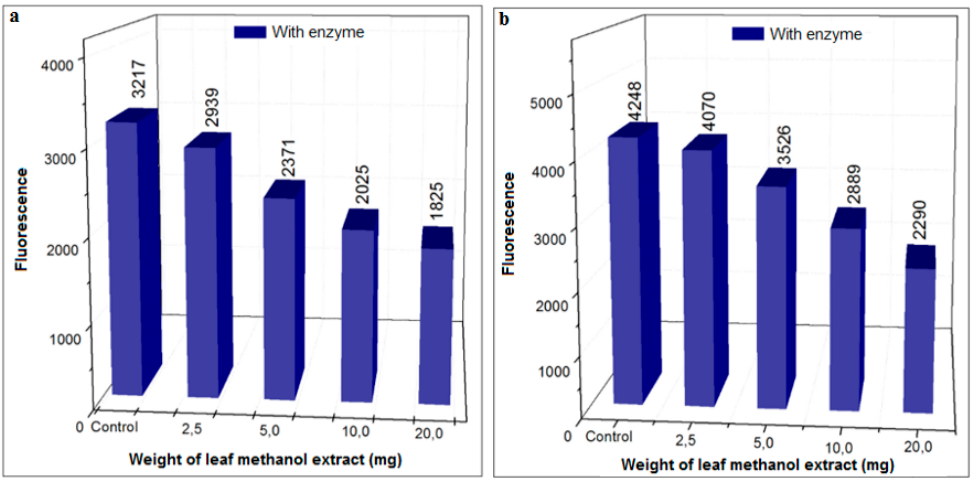
Figure 9. Inhibition of AGEs formation using different concentrations of methanol leaf extract of HS (37 °C) in the presence of XO in pure phosphate buffer (pH = 6.6). ( a ) Procedure with glucose, 48 h incubation; ( b ) procedure with MGO, 3 h incubation.